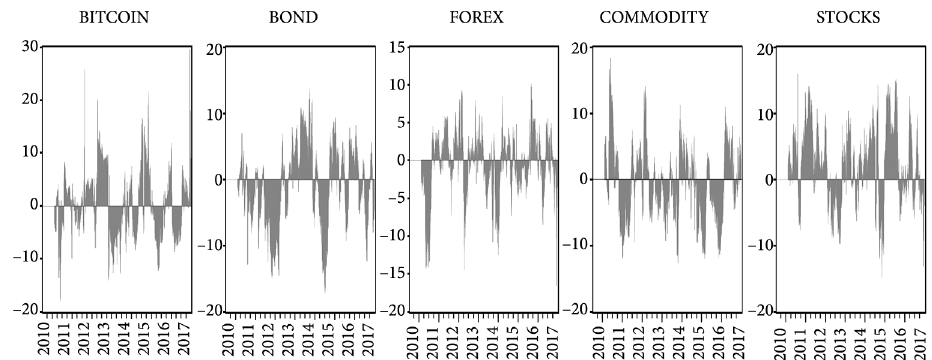
Figure 4. Net volatility spillover, U.S. bitcoin and financial markets